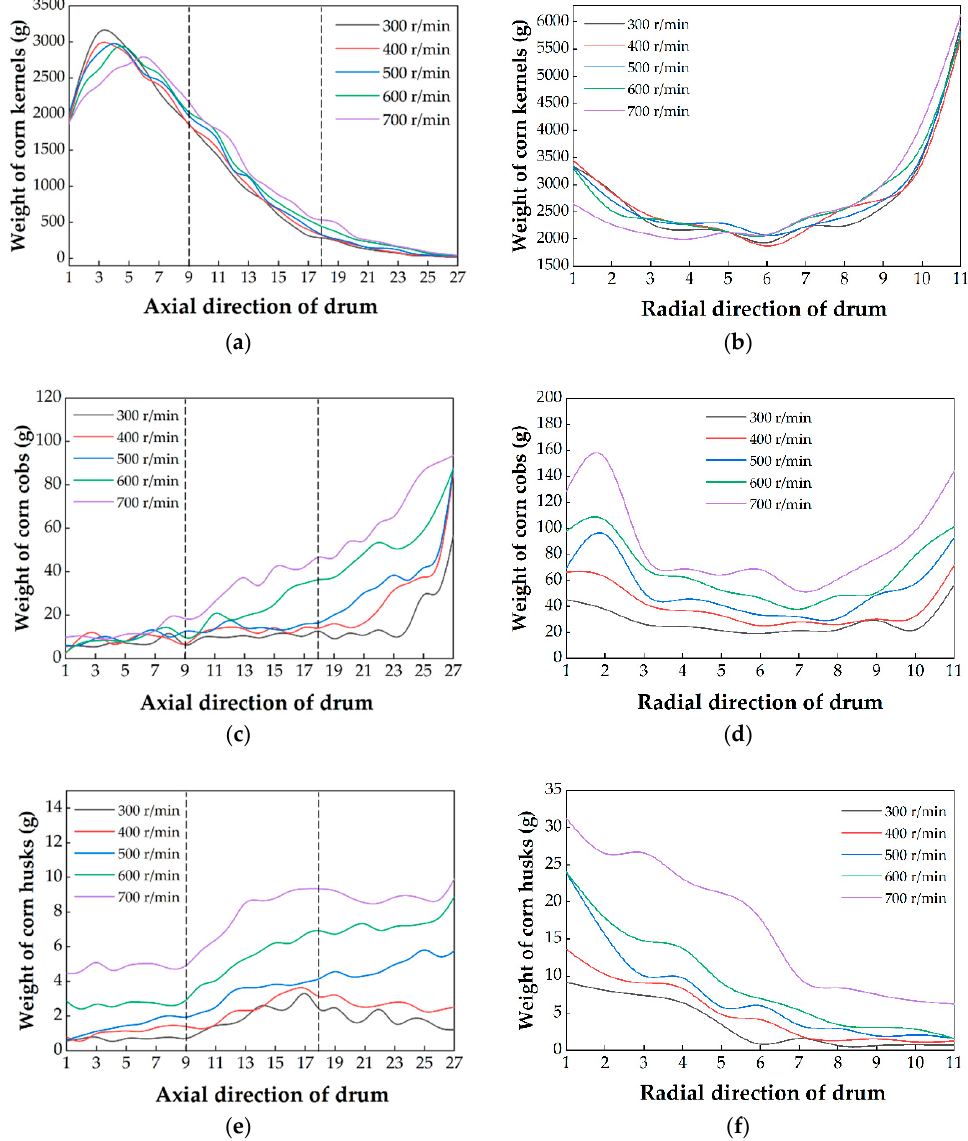
Figure 10. Weight distribution of components for different feed rates. Weight distribution curves in the axial and radial direction of ( a , b ) corn kernels; ( c , d ) corn cobs; and ( e , f ) corn husks. As shown in Figure 10a, the weight of corn kernels was first increased from row 1 to rows 2–6, and then decreased to the end in the axial direction. The weight reached the highest value at row 3 when the drum speed was 300 r/min. Meanwhile, the peak weight shifted to row 6 when the drum speed increased to 700 r/min. This shift was due to changes in the linear velocity caused by the drum speed. The mixture moved backward faster with higher linear velocity. In the radial direction, the weight on the left and right sides was always greater than that in the middle (Figure 10b). The greatest kernel weight was in column 11, while the lowest weight was in column 6. In particular, the weight in column 11 was about 2.5 times that in column 6. Thus, the weight presented prominent